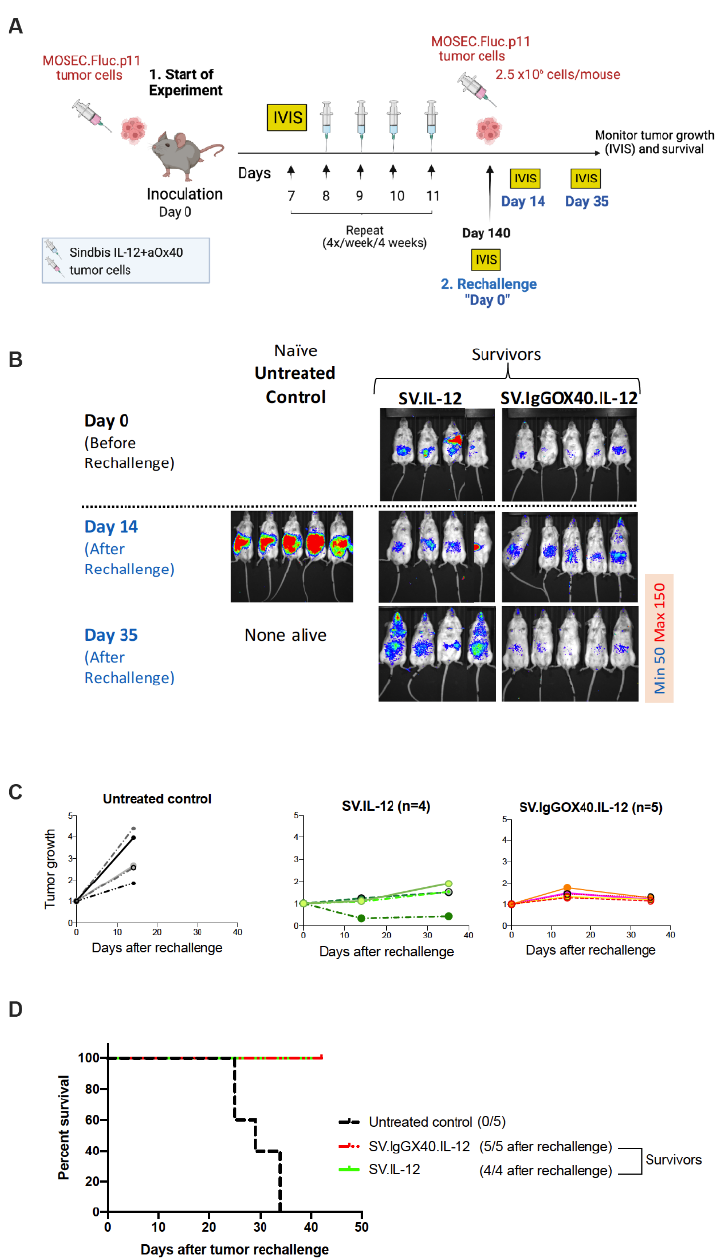
Figure 5. Survivors rechallenged with ovarian tumor cells are protected from tumor recurrence. ( A ) Experimental protocol for the ovarian cancer model used in ( B – D ). C57BL/6 mice were given an i.p. injection of SV.IL-12 or.SV.IgGOX40.IL-12 at the indicated times after injection of 2.5 × 10 6 MOSEC.Fluc.p11 cells on day 0. Survivor treated mice were given another injection of 2.5 × 10 6 MOSEC.Fluc.p11 cells at day 140. At this time (rechallenge day 0), naive control mice were also injected with MOSEC.Fluc.p11 cells. ( B ) Representative bioluminescence images of control and treated tumor bearing mice. ( C ) MOSEC.Fluc.p11 tumor growth curves shown as fold changes relative to luminescence on day 0 of the same mouse (RLU day X/ RLU first day). Each line represents an individual mouse. ( D ) Survival plot of control and treated mice bearing peritoneally disseminated MOSEC.Fluc.p11 tumors.